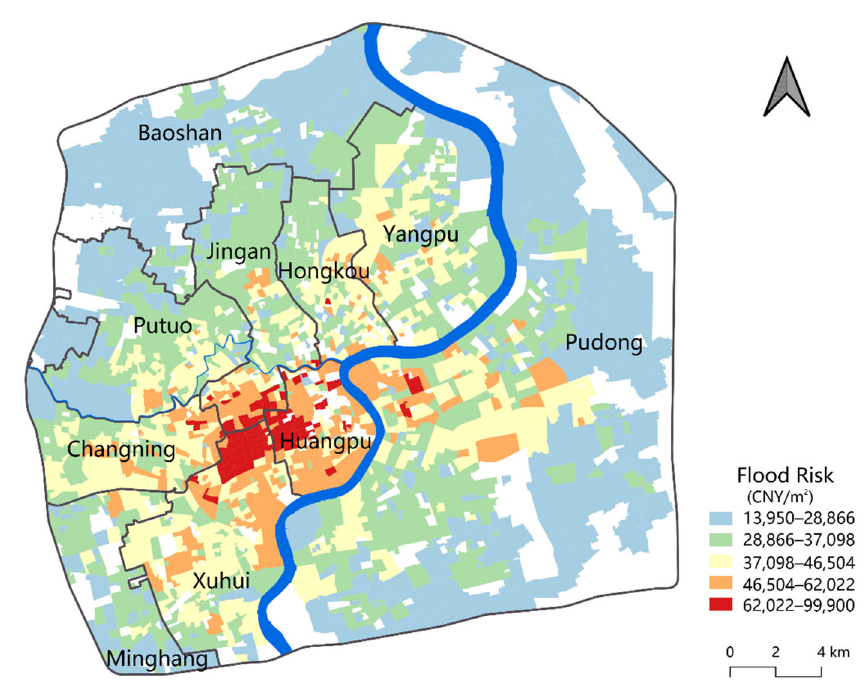
Figure 12. Flood risk at the neighborhood committee scale.